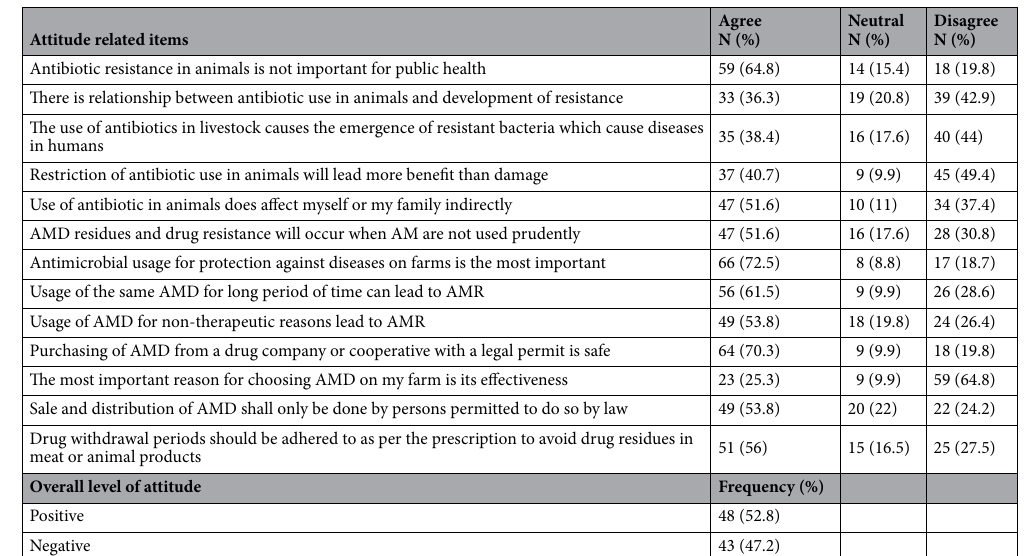
Table 6. Attitude of animal farm owners/workers towards antimicrobial resistances and use in Amhara regional state, North Western Ethiopia (N = 91).